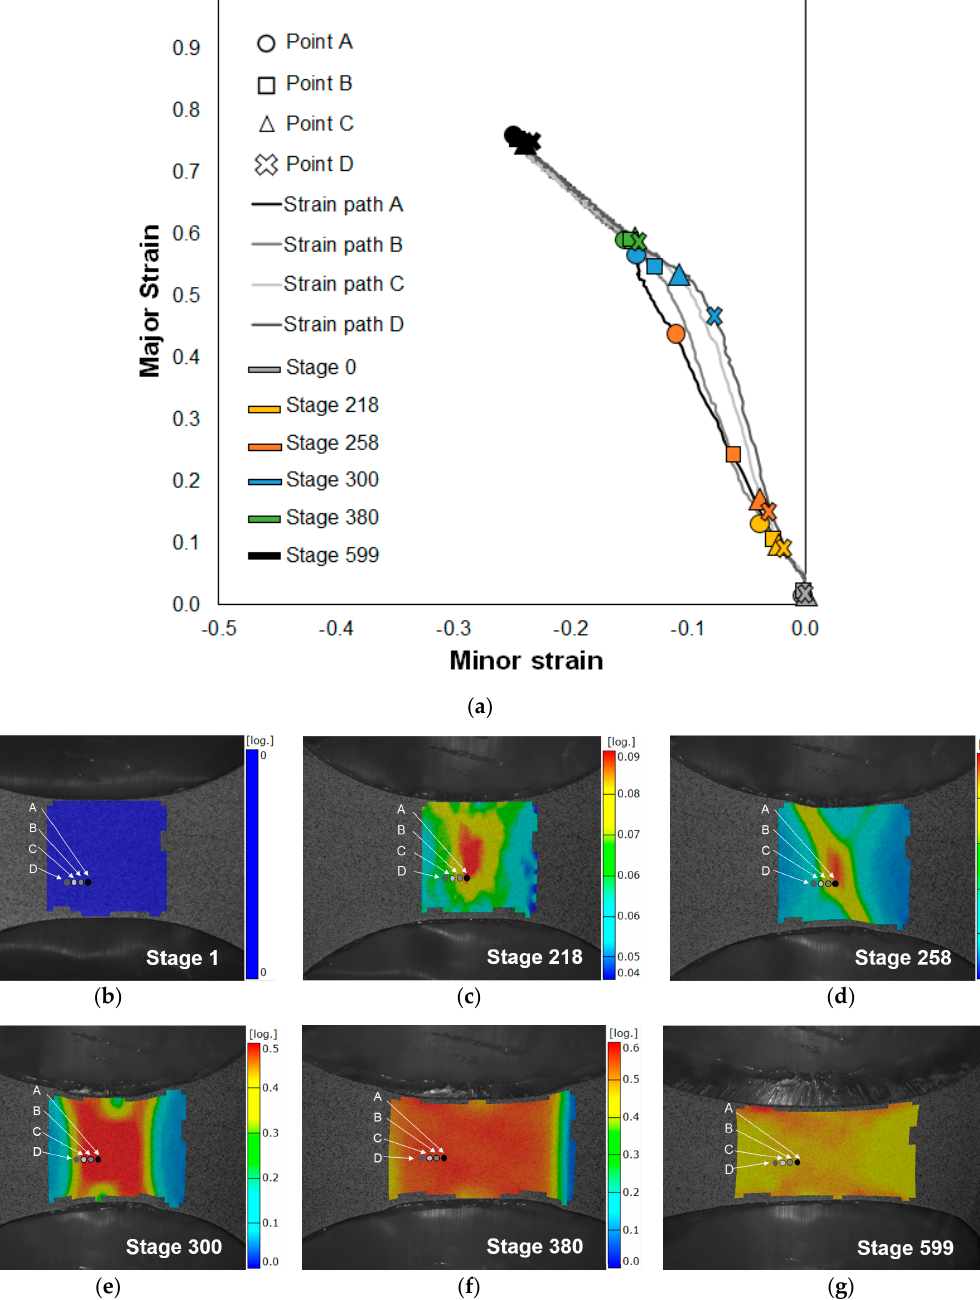
Figure 6. ( a ) Strain path evolution along a section perpendicular to the crack of a TS specimen for different stages through the Nakajima test. Measured major strains obtained by the DIC system for several stages: ( b ) No deformation; ( c ) onset of necking; ( d ) and ( e ) steadily neck propagation; ( f ) ceasing of neck propagation and ( g ) fracture.